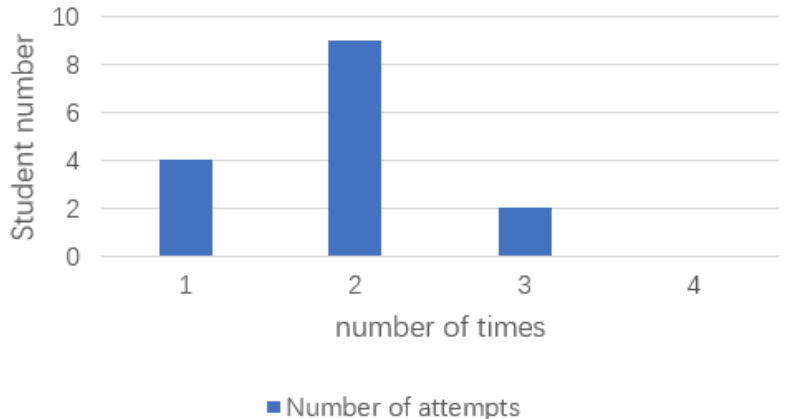
Figure 17. Number of successful